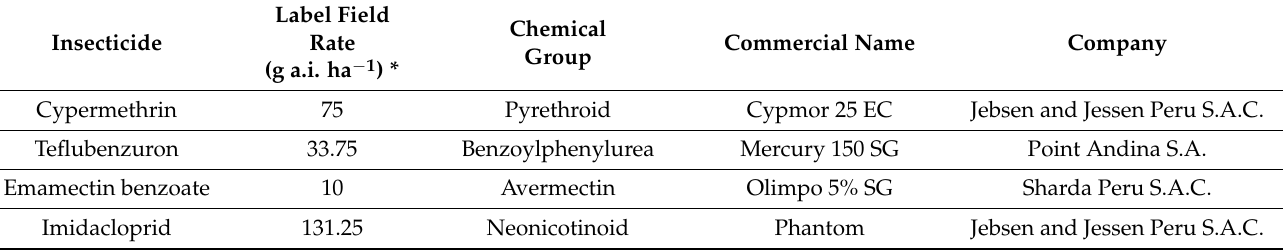
Table 6. Insecticide specifications used in the